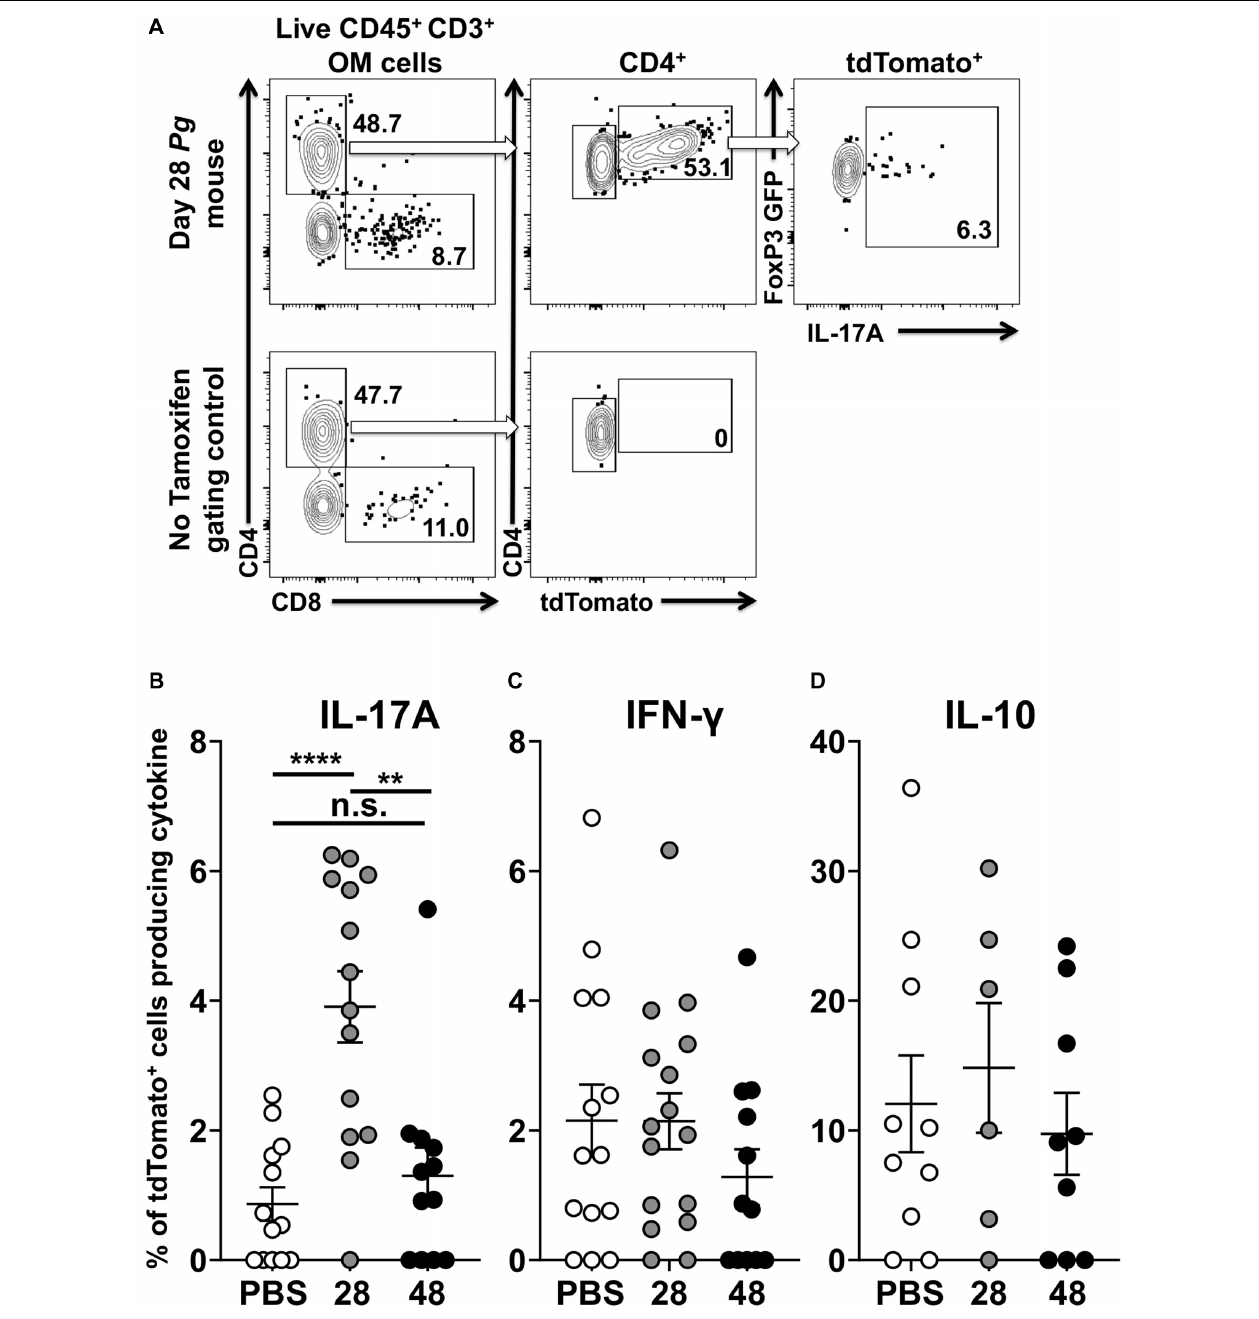
FIGURE 6 | P. gingivalis induces transient IL-17A expression in Treg cells in the oral mucosa. Single cell suspensions were isolated from oral mucosa of P. gingivalis inoculated mice at 28 or 48 days. Single cell suspensions were cultured and stimulated with PMA/ionomycin in the presence of brefeldin A. Cultured cells were surface stained with anti-mouse CD3, B220, CD8 α , and CD4 fluorochrome-conjugated mAbs to identify tdTomato + CD4 + Treg cells by flow cytometry (gated as CD3 + CD4 + tdTomato + B220 − CD8 α − ) and then intracellular stained with anti-mouse IL-17A, IFN- γ , and IL-10. (A) Representative flow cytometry plots showing gating strategy to identify the Foxp3 cre -tdTomato + cell population within the oral mucosa also expressing Foxp3-GFP and IL-17A. Numbers indicate the % of cells within the associated gate. (B–D) Means of the frequency of tdTomato + CD4 + T cells expressing IL-17A (B) , IFN- γ (C) , or IL-10 (D) at day 28 (gray circle) and 48 (black circle) were compared to sham controls (white circle) using two-tailed Student’s t -test and presented as means ± SEM. ** p < 0.01, **** p < 0.0001. Each circle represents two pooled oral mucosae from two mice.